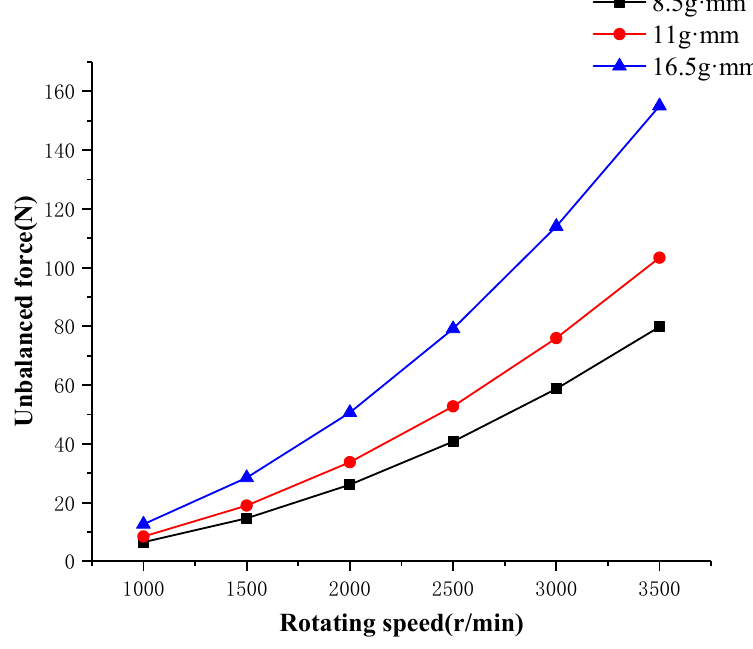
Figure 7. Unbalanced force before balancing.